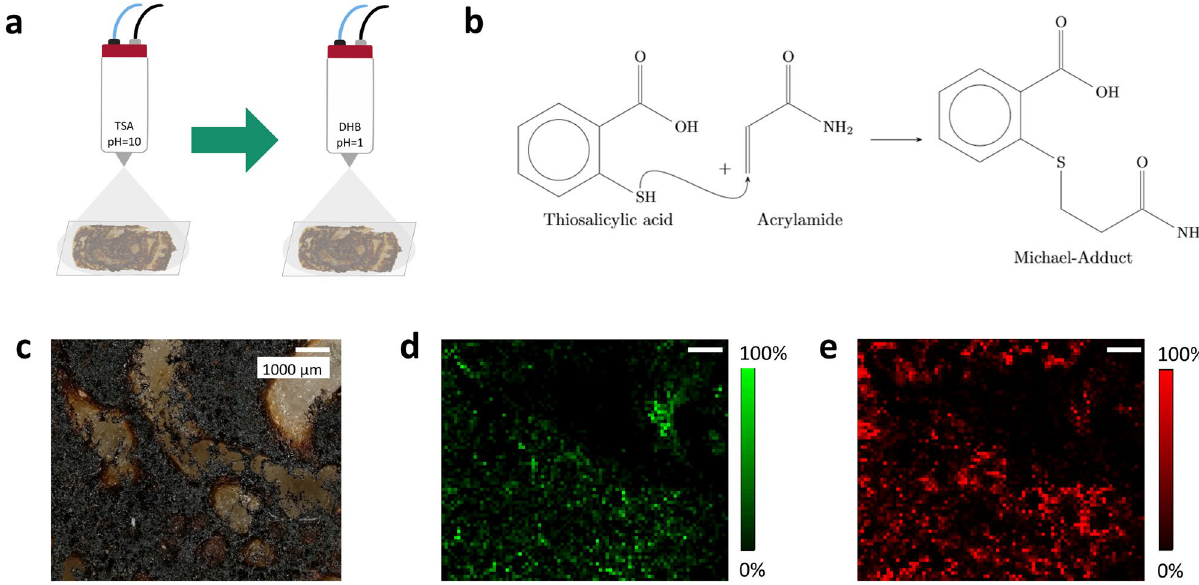
Figure 5. in-situ Derivatization of acrylamide on pancake surface. Raster size: 89 × 75 pixels, pixel size: 100 µm. ( a ) Scheme of the sample preparation: Application of thiosalicylic acid in alkaline solution followed by 2.5-dihydroxybenzoic acid in acidic solution. ( b ) Derivatization reaction of thiosalicylic acid and acrylamide. ( c ) Microscope image of the measured pancake surface. ( d ) MS image of acrylamide [M + H] + , m/z 72.04439. ( e ) MS image of the Michael-adduct [M + Na] + , m/z 248.03519 (isotope distribution, see supplementary, Fig.